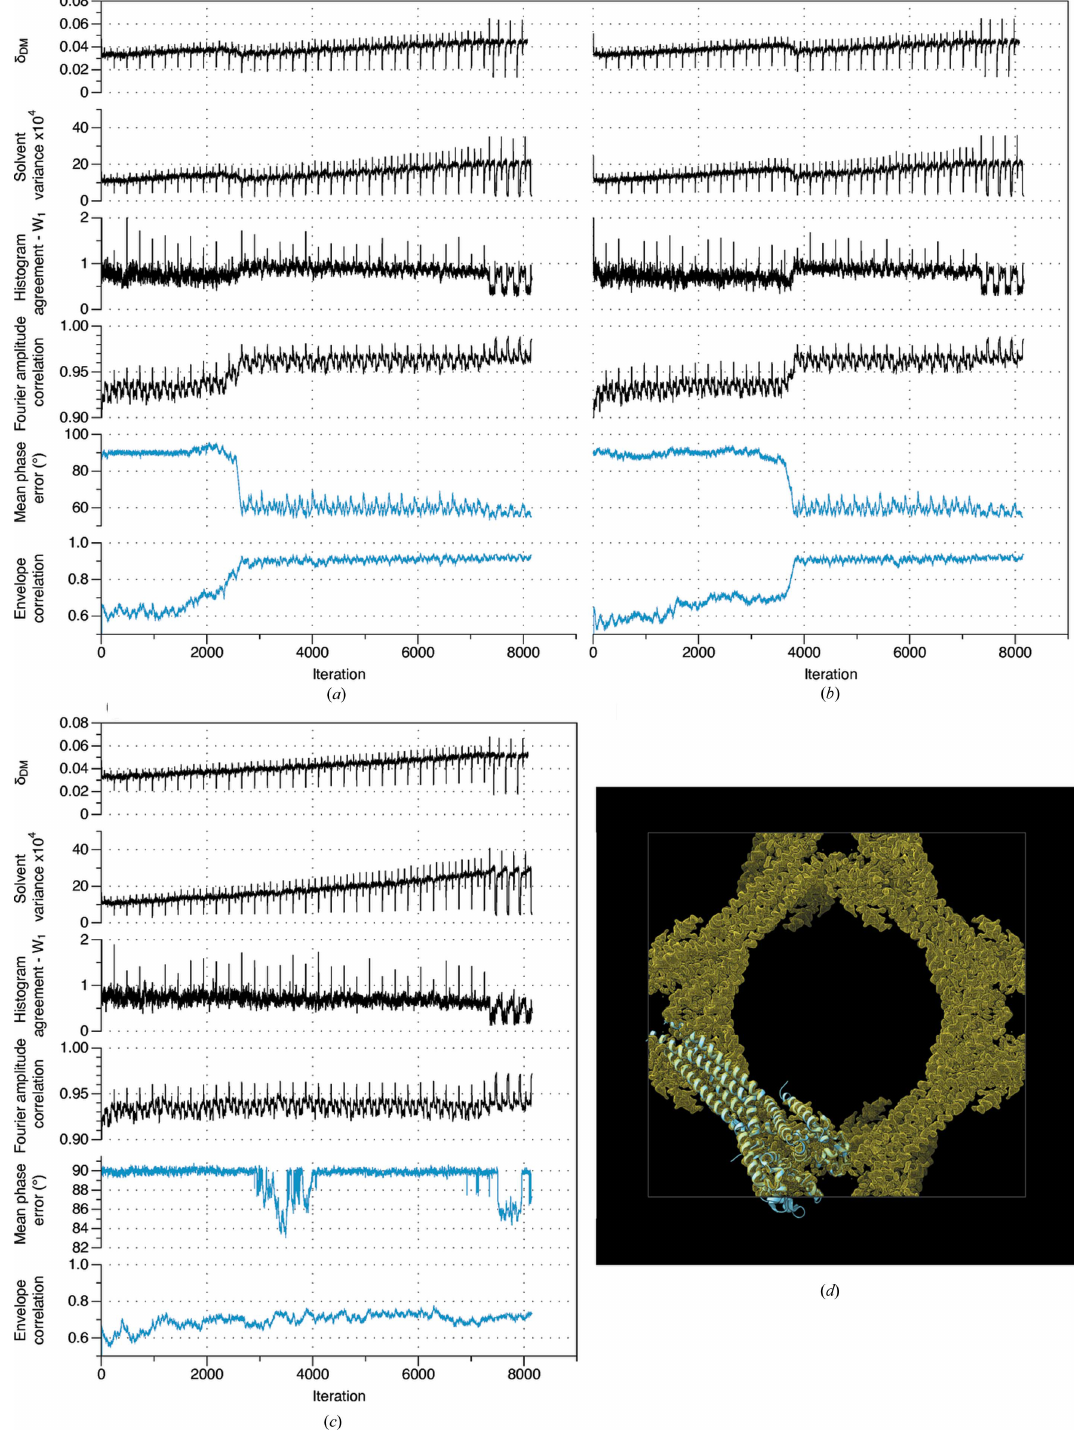
Figure 5 Phase determination for test case 5hk7 (Arrigoni et al. , 2016) (solvent fraction 0.833, 2.95 A˚ resolution). ( a ) and ( b ) The trajectories of two successful runs. ( c ) The trajectory of an unsuccessful run. These runs were initiated with the same molecular envelope [Fig. 4( b )] but with different random phase sets. Across the first 7200 iterations, the discontinuities apparent every 240 iterations are associated with the steady reduction in data apodization, while the discontinuities apparent every 60 iterations are associated with switching of the DM algorithm parameter (cid:2) between two values. In parts ( a )–( c ), plotted from top to bottom, as a function of iteration, are the convergence indicator of the DM algorithm ( (cid:3) DM ); the variance in the solvent region; the Wasserstein distance between reconstructed and reference histograms in the protein region; the correlation between reconstructed and measured Fourier amplitudes; the weighted mean absolute difference between reconstructed and model phases; and the correlation between the reconstructed and model envelope. The metrics that could be followed during determination of an unknown structure are shown in black, while the metrics that assess agreement with the known solution are shown in blue. ( d ) Consensus electron-density map determined from 10 independent runs, with the molecular structure of the bacterial sodium channel (5hk7) shown in ribbon 660 Kingston and Millane (cid:2) Phasing high-solvent protein crystals IUCrJ (2022). 9 , 648–665